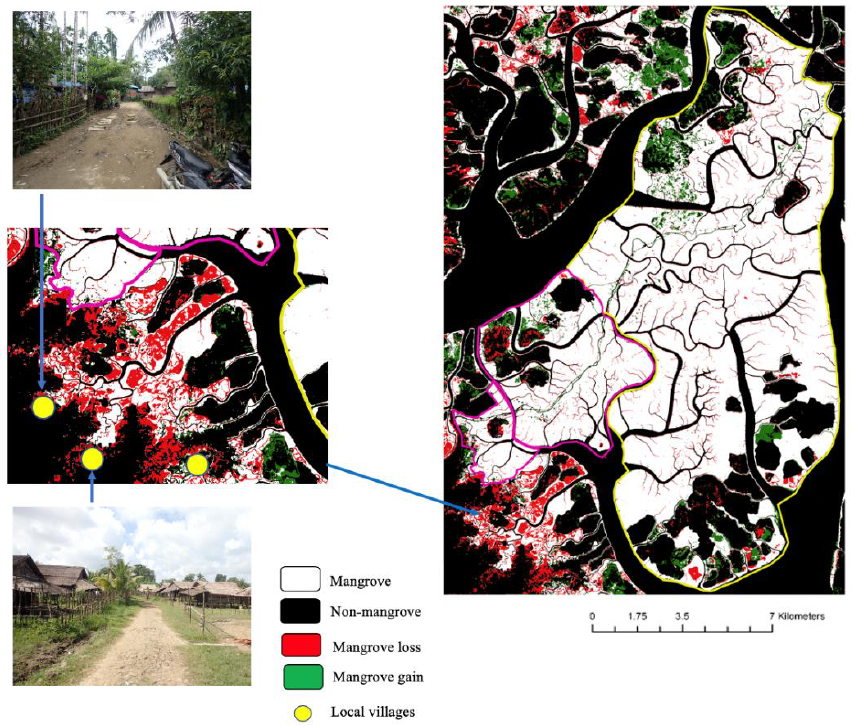
Figure 18. Shrimp pond expansion by local villages near the WRMF between 2015 and 2020.